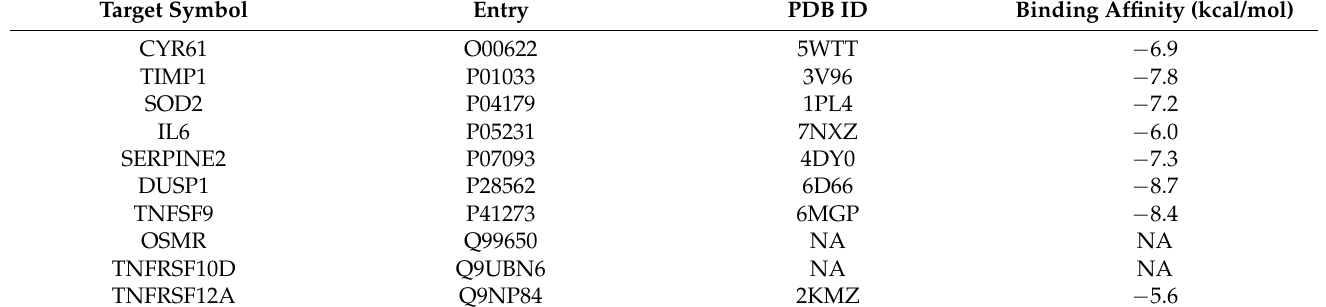
Table 2. Molecular docking results of 10 key expressed proteins.